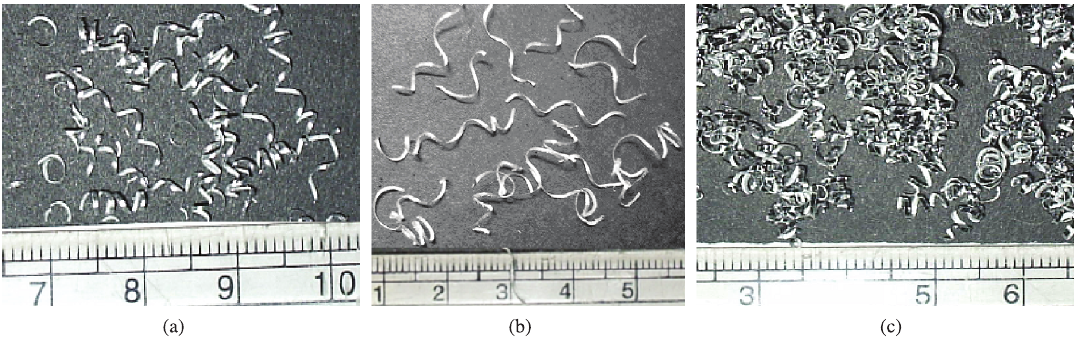
Figure 4. Chips formed during the machining of Al 2219/SiCp for both the composites at a constant cutting distance of 50 mm, cutting speed of 110 m/min, feed rate of 0.1 mm/rev, depth of cut of 0.3 mm for (a) carbide tool (b) Coated Carbide tool and (c)PCD tool.